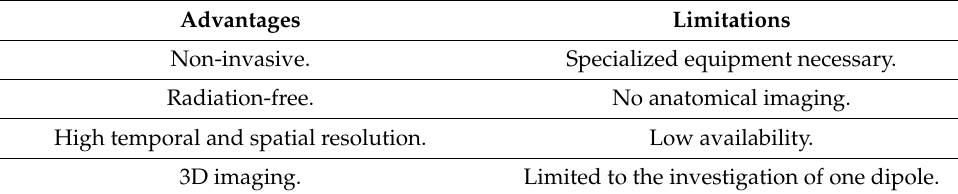
Table 3. Advantages and limitations of magnetic marker monitoring.